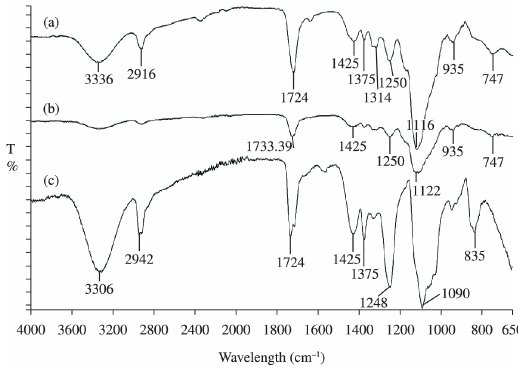
Figure 2. FTIR spectra of (a) PVA, (b) PVA/SiO SiO